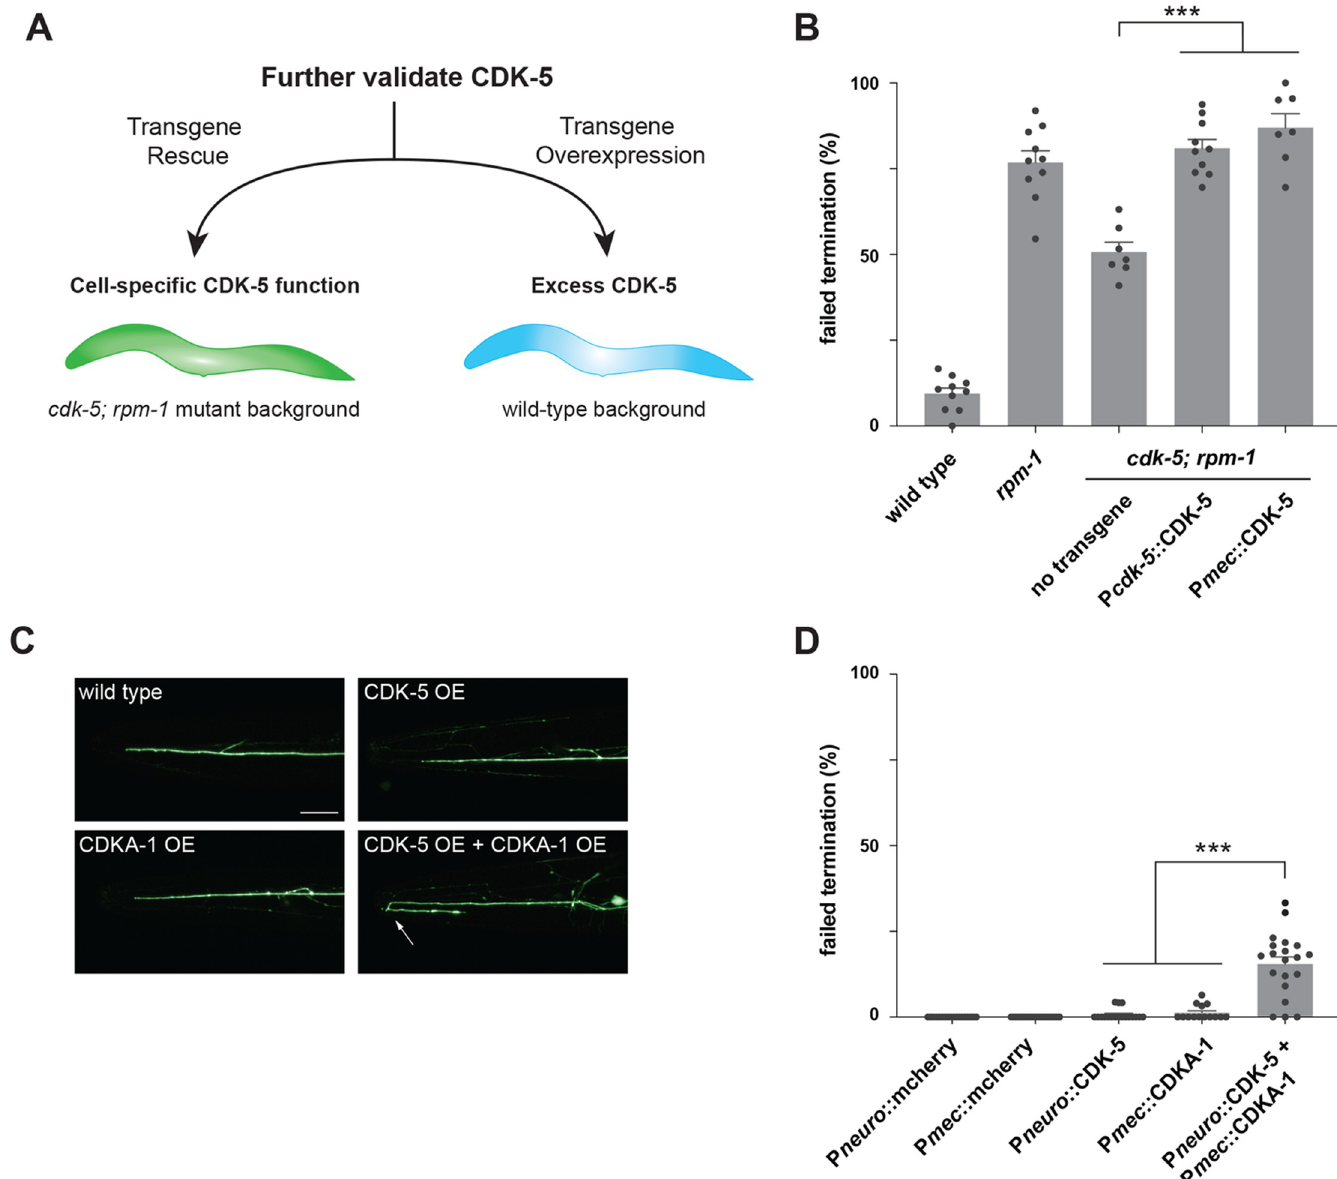
Fig 4. Transgenic rescue and overexpression studies indicate CDK-5 functions cell-autonomously to regulate axon termination. A ) Schematic of transgenic workflow for evaluating CDK-5 rescue, cell-autonomous function and overexpression. B ) Quantitation of axon termination defects in ALM neurons indicates transgenic CDK-5 expressed using native promoter (P cdk-5 ) or promoter for mechanosensory neurons (P mec ) rescues reduced axon termination defects in cdk-5; rpm- 1 double mutants. C ) Representative images of axon termination in ALM neurons of transgenic animals overexpressing indicated constructs. Axon termination is impaired with overexpression of both CDK-5 and CDKA-1(p35). D ) Quantitation of ALM axon termination defects caused by transgenic overexpression of indicated constructs. For all experiments, means (bars) are shown from data collected from 3 or more independent transgenic lines (two counts/line, black dots) for each genotype. Error bars indicate SEM. Significance assessed using Student’s t -test with Bonferroni correction. ��� p < 0.001. Scale bars 20 μ m.